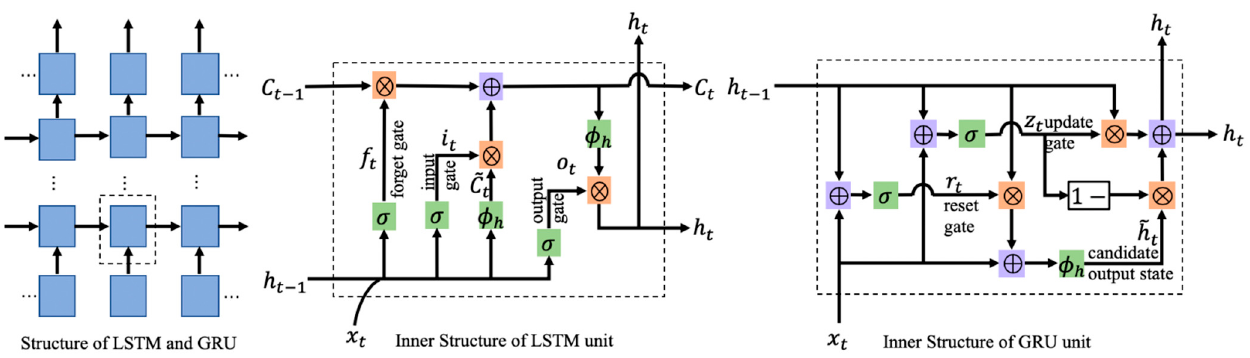
Figure 4. LSTM and GRU networks.